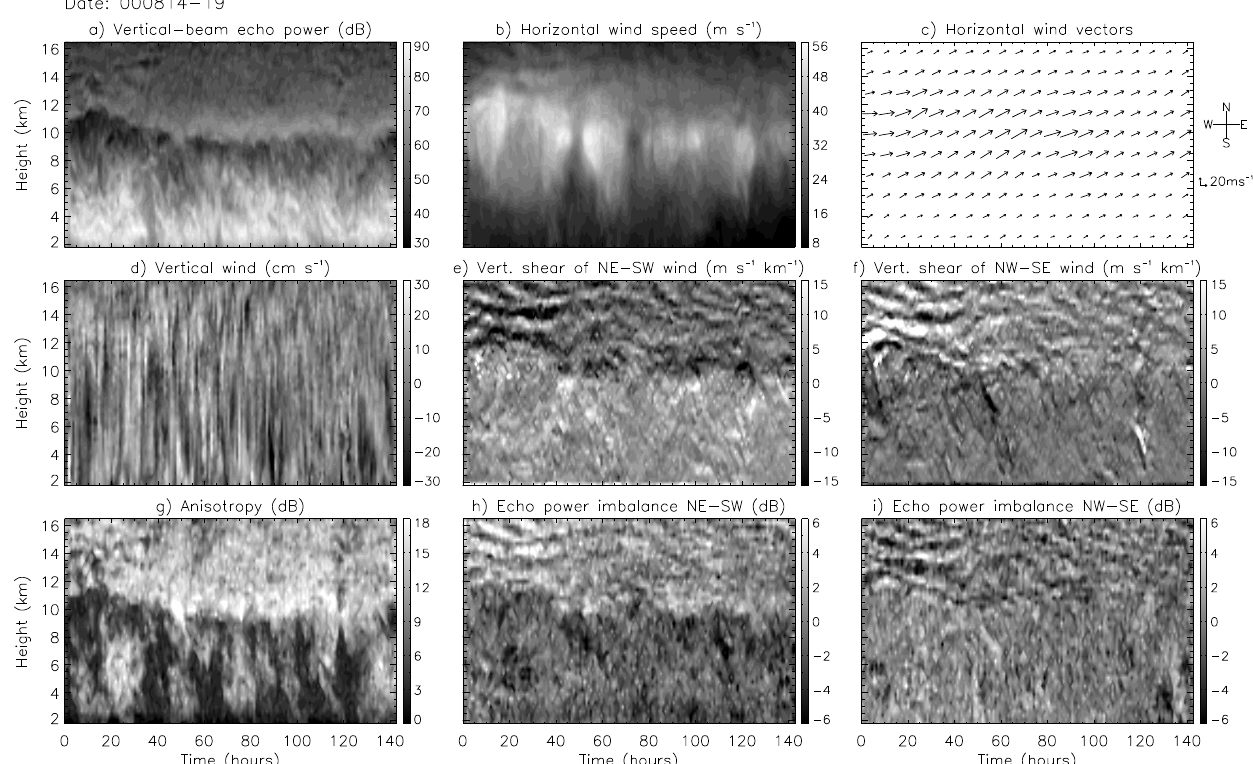
Fig. 1. Height-time plots of (a) vertical-beam echo-power, showing the tropopause height near 9-11km, (b) horizontal wind speed, (c) hori- zontal wind vectors, (d) vertical wind component measured by averaging radial velocities from 2 pairs of symmetric beams 6 ◦ off-vertical, (e) vertical shear of the horizontal wind component measured by the symmetric pair of beams at 6 ◦ off vertical, aligned approximately NE–SW (N26 ◦ E–S26 ◦ W), (f) same as (e) for the beam pair aligned approx. NW–SE (N64 ◦ W–S64 ◦ E), (g) difference between vertical and average 6 ◦ echo powers to show the VHF aspect sensitivity of the air, (h) echo-power imbalance between the symmetric pair of beams aligned NE–SW, (i) same as (h) for the beam pair aligned NW–SE. The echo-power imbalances in (h) are the central observations in the